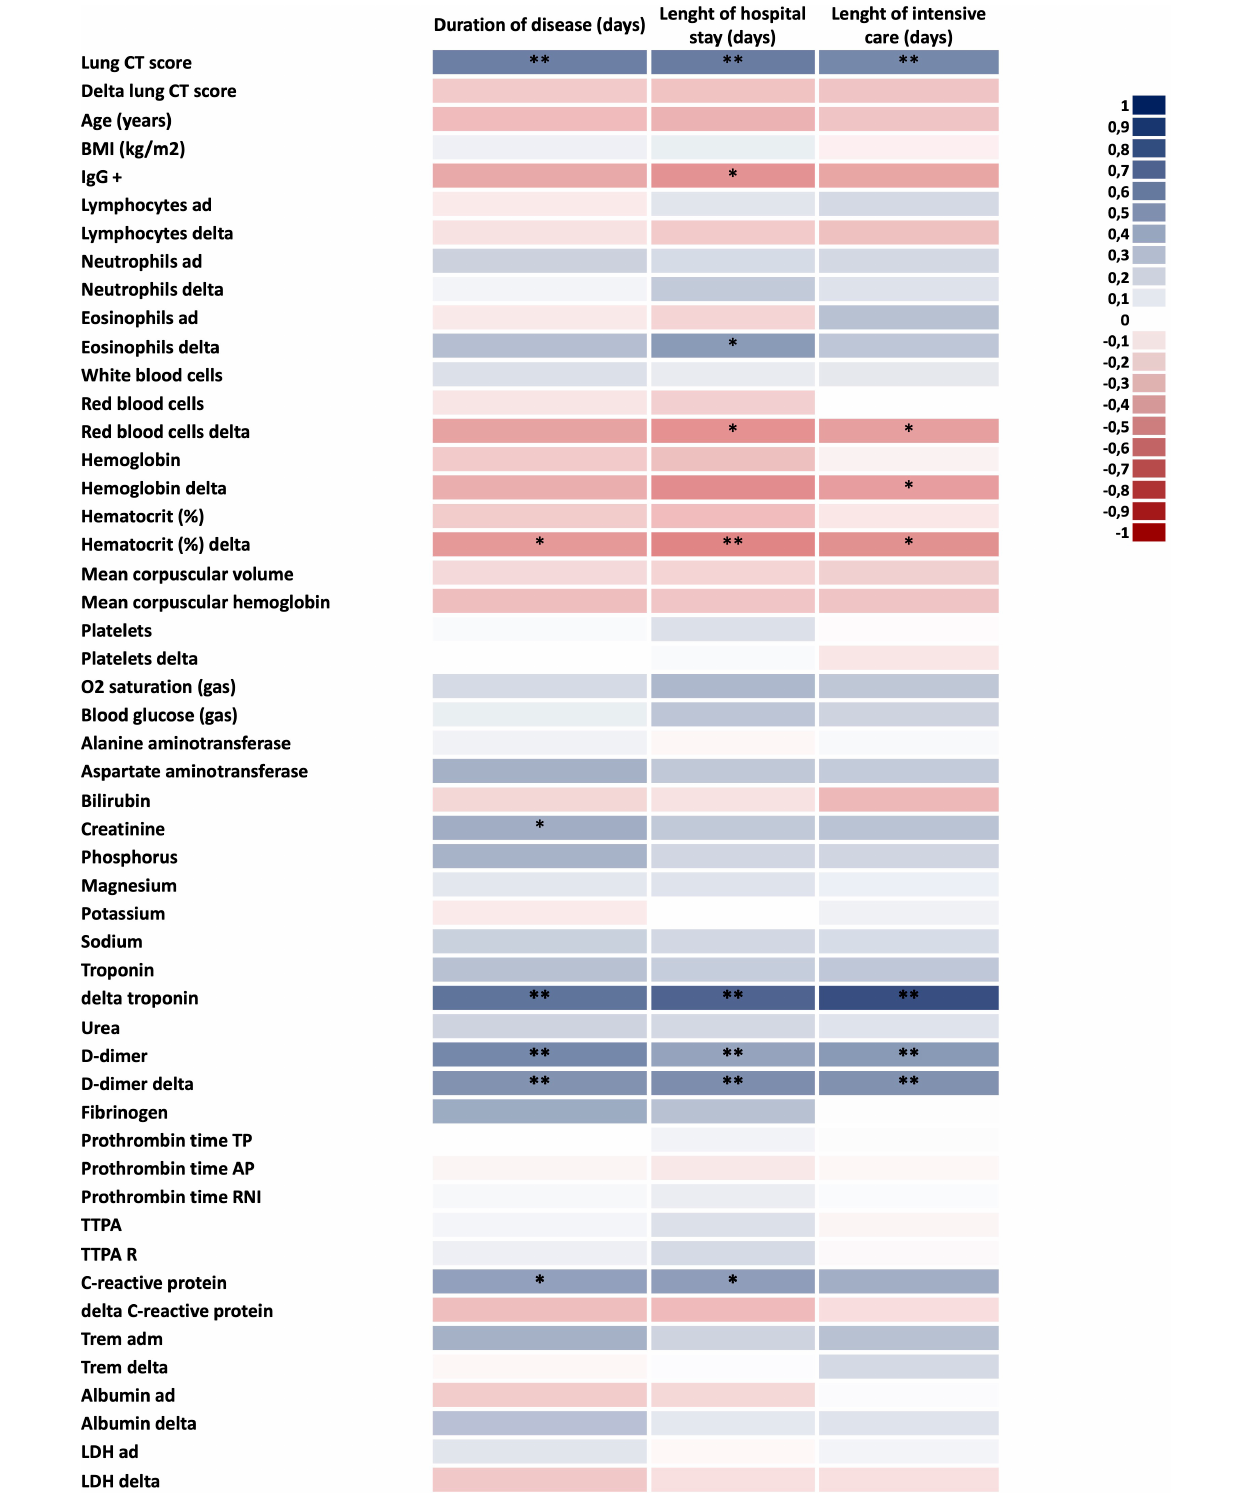
FIGURE 1 | Defining the factors associated with COVID-19 severity. Heatmap of clinical and laboratorial parameters potentially associated with COVID-19 severity. Blue colors mean direct correlation; red colors mean inverse correlation. In all n = 28; ∗ p < 0.05 and ∗∗ p < 0.01. BMI, body mass index; CT, computed tomography; ICU, intensive care unit; LDH, lactate dehydrogenase; and TTPA, partial activated thromboplastin time.